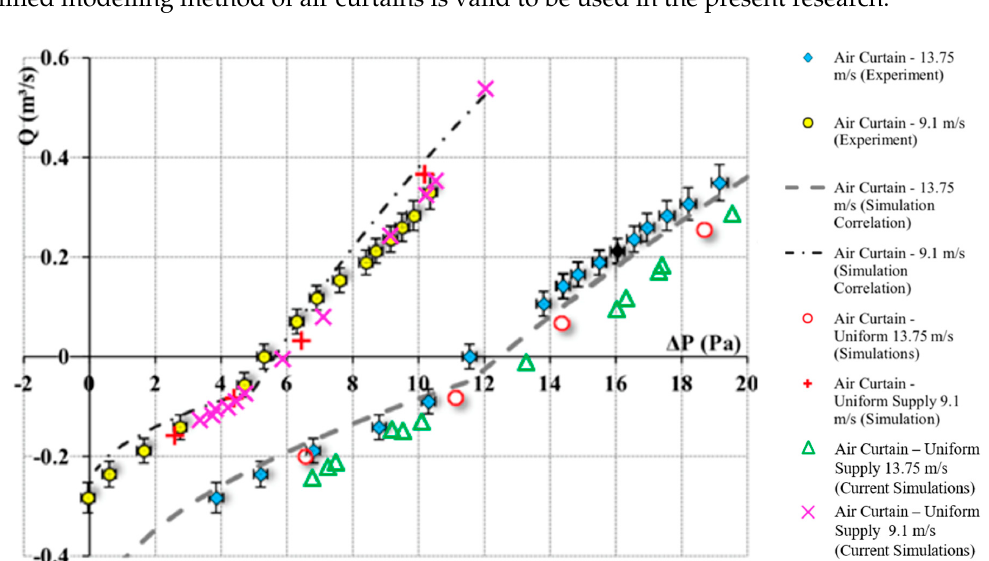
17 of 27 Figure 7. ( a ) The computational domain of the jet model from the present study. ( b ) The locations of dry-bulb temperature (DBT) measurement points on the outlet plane (modified from [48]). ( c ) DBTs comparison between current CFD results and previous experimental measurements [48]. ( d ) DBTs comparison between previous CFD results [49] and previous experimental measurements [48]. The air curtains used in the present study were modelled as supply slots, according to a previous